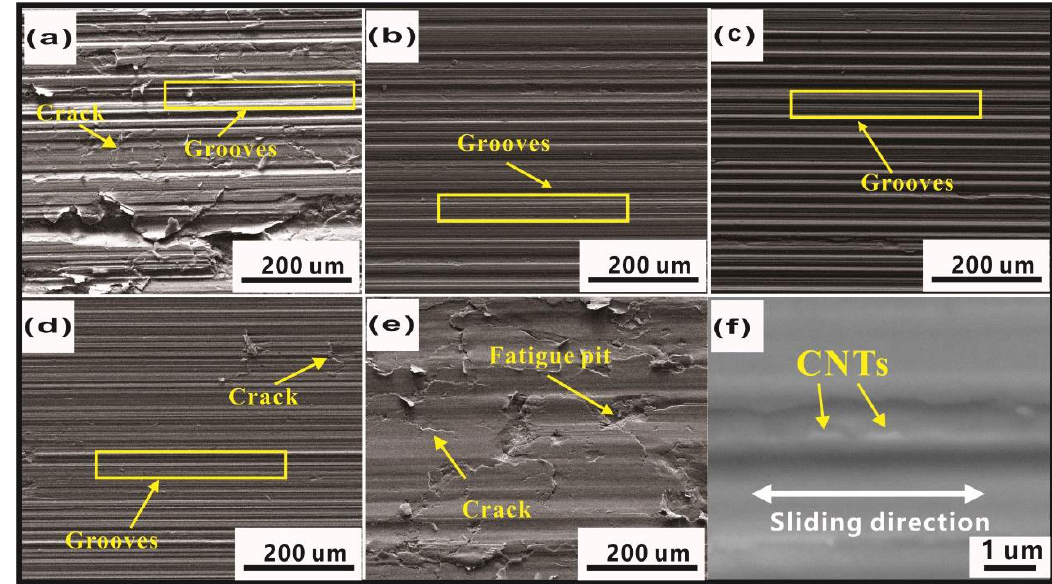
Figure 10. SEM images of worn surface under boundary lubrication conditions of Cu / CNT composites containing: ( a ) 0, ( b ) 0.3, ( c ) 0.6, ( d ) 1.2, and ( e ) 1.8 vol.% CNTs under a load of 40 N and ( f ) highly magnified image of typical grooves.